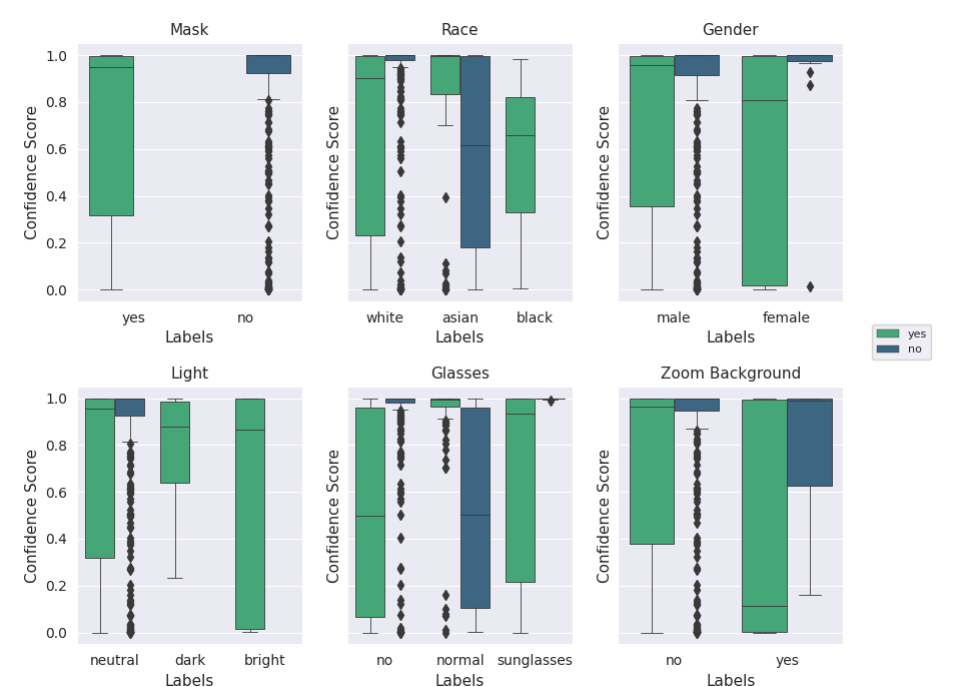
Figure A4. Box plot of categorical labels vs. confidence scores for only good quality images, as qualitatively evaluated, using the augmented MobileNetv2 model. For each category and its labels, ‘mask’ and ‘no mask’ scores are plotted beside each other. The median is represented by the center line of each box while the upper and lower bounds represent the respective quartiles. Outliers are represented by diamond